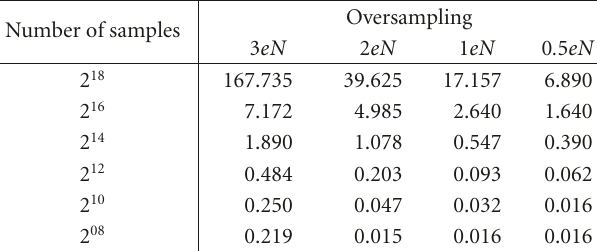
Table 2: Elapsed times in seconds. Times for FMT algorithm only.